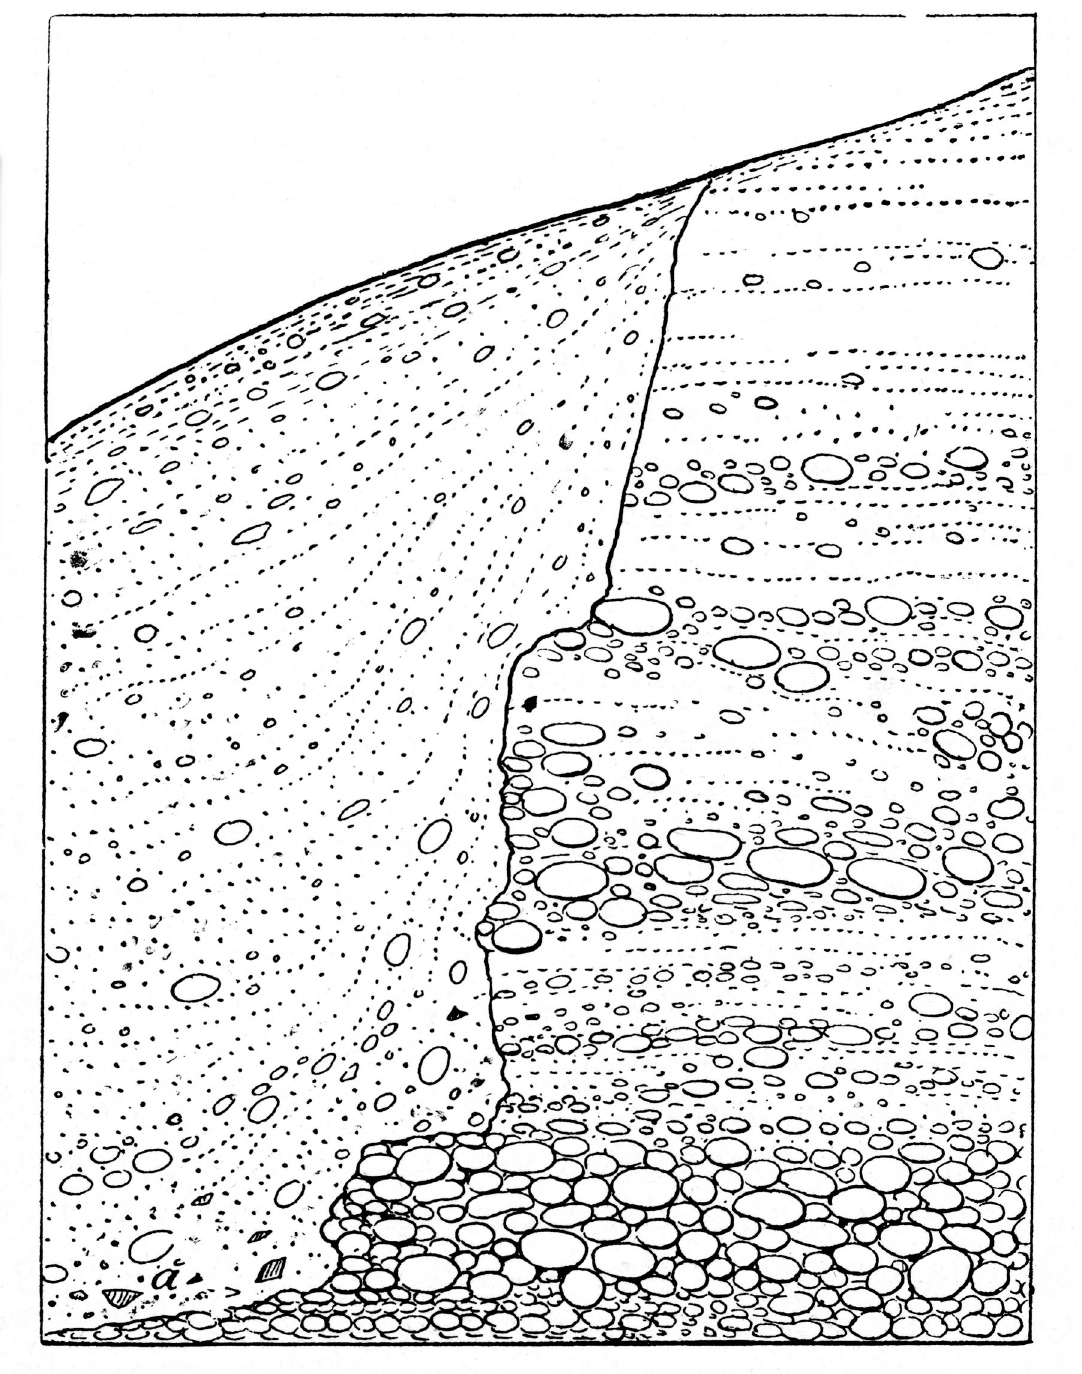
Figure 5. Cut bank in the natural deposits of quartzite cobbles and boulders at Piney Branch interpreted as a “quarry face” by Holmes. After Holmes 1897: fig. 8. [Original caption: Section of bowlder beds exposed in quarry face 12 feet in